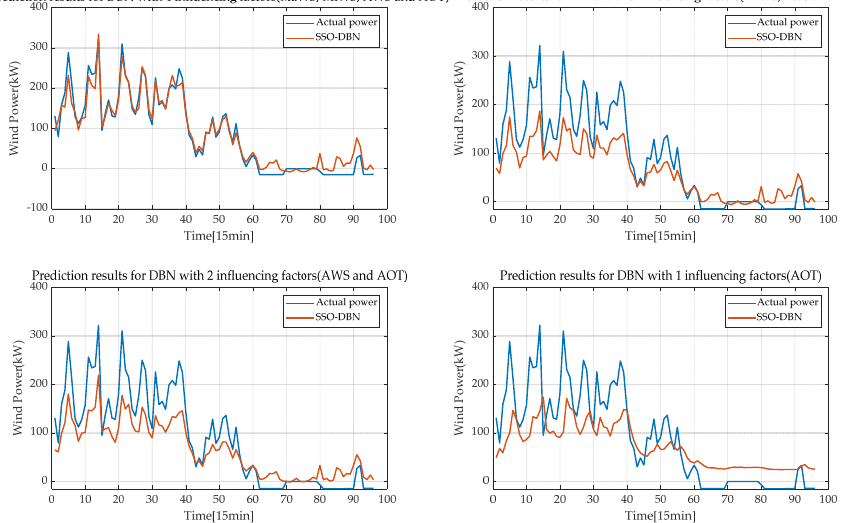
Figure 7. Wind power prediction results under different inputs.